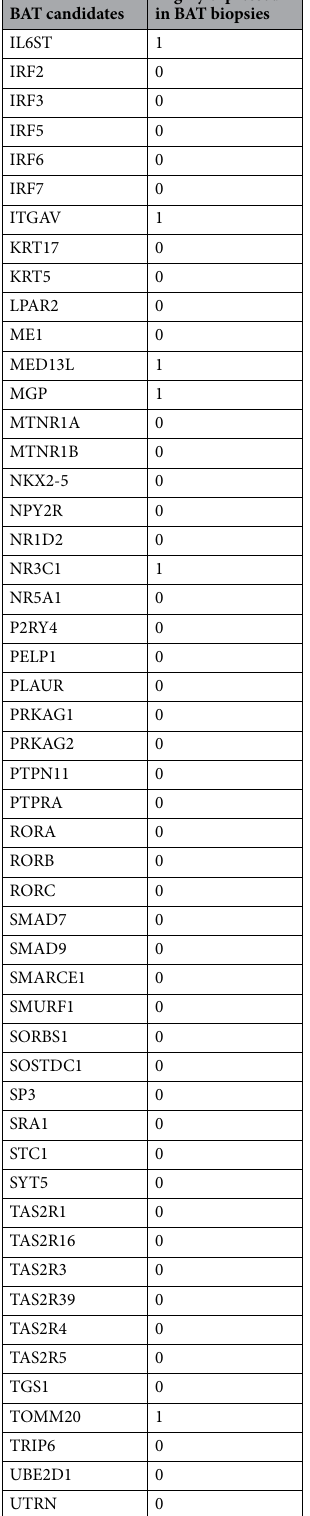
Table 2. List of BAT candidates, along with information about their expression in two microarray studies analyzing BAT biopsies 15,16 . 1 = Above the 95th percentile of gene expression in any of the two studies; 0 = Below the 95th percentile of gene expression in both studies. See Supplementary Appendix S1 for full gene